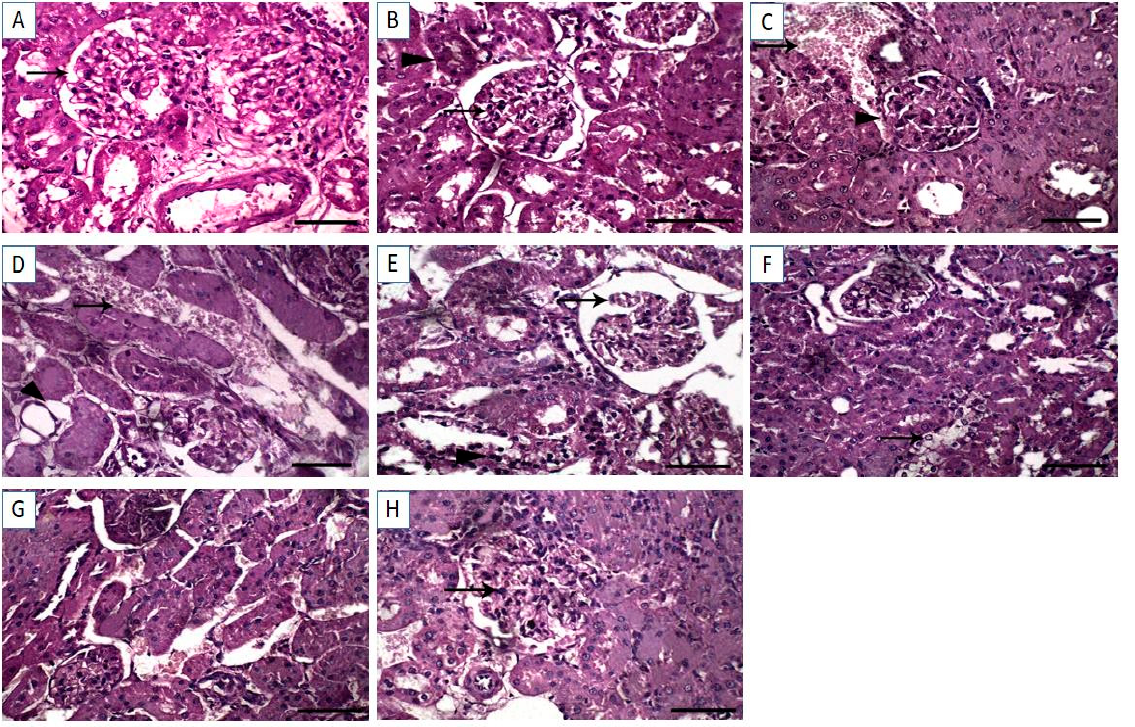
Figure 5. Light photomicrographs of renal tissues (sections stained with H &E). ( A , B ) control and cinnamon groups: Normal renal glomeruli and normal renal tubules. ( C ) DFS group: revealed proliferation of the renal glomeruli and marked hemorrhage in interstitial tissue displacing renal parenchyma ( D ) OTC group: Showing hemorrhage in interstitial tissue displacing renal parenchyma. ( E ) DFS + OTC group: Congestion in the renal glomeruli and necrosis in the renal tubular epithelium were observed. ( F ) DFS + Cin group: Degenerative changes in the renal tubular epithelium. ( G ) OTC + Cin group: Fairly normal histological structure, and ( H ) DFS + OTC + Cin group: Revealing mild proliferation of the renal glomeruli and normal renal tubule. Scale bar = 100 µm.